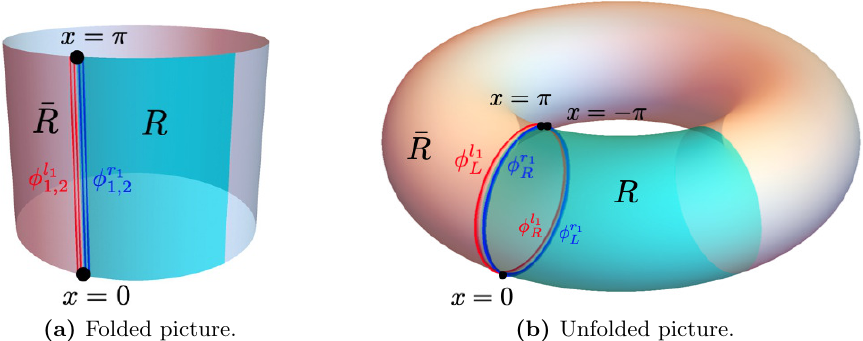
Figure 2 . \Open string" modes in the folded picture and \closed string" modes in the unfolded